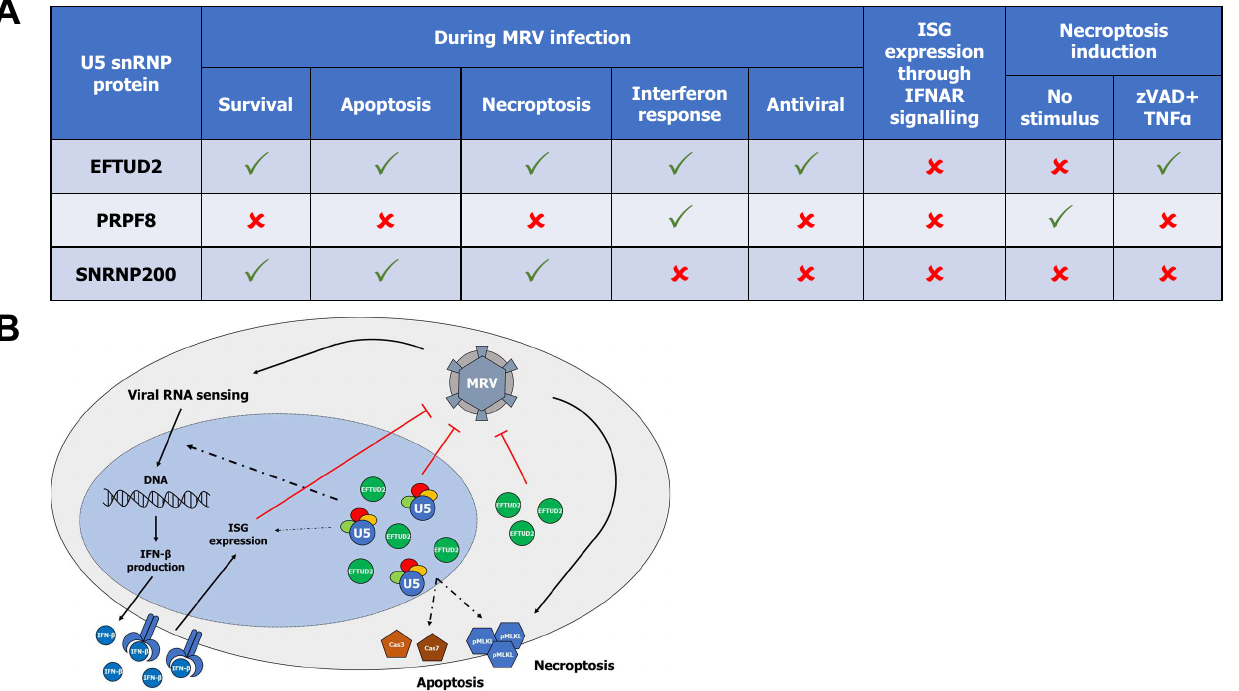
Figure 7. Summary of the involvement of U5 snRNP core proteins in virus–host interactions. ( A ) Table depicting the respective roles of EFTUD2, PRPF8, and SNRNP200 in the interferon response pathway, apoptosis, and necroptosis. ( B ) Model depicting the roles of EFTUD2 during MRV infection. EFTUD2 (either cytoplasmic or nuclear; and either in the U5 snRNP or by itself when located in the nucleus) exerts an antiviral role on MRV replication (red arrow). MRV infection elicits both apoptosis and necroptosis (black arrow), which require the presence of EFTUD2 to normally proceed (dotted arrow). EFTUD2 is also required for the basal expression of ISG (thin dotted arrow), but its principal impact on the IFN response pathway during infection lies somewhere between the sensing of viral RNA and the production of IFN (dotted arrow). ISG expression exerts an antiviral effect on MRV (red arrow), and might explains, at least in part, the antiviral effect of EFTUD2, since MRV actively trigger this pathway through the sensing of its viral RNA (black